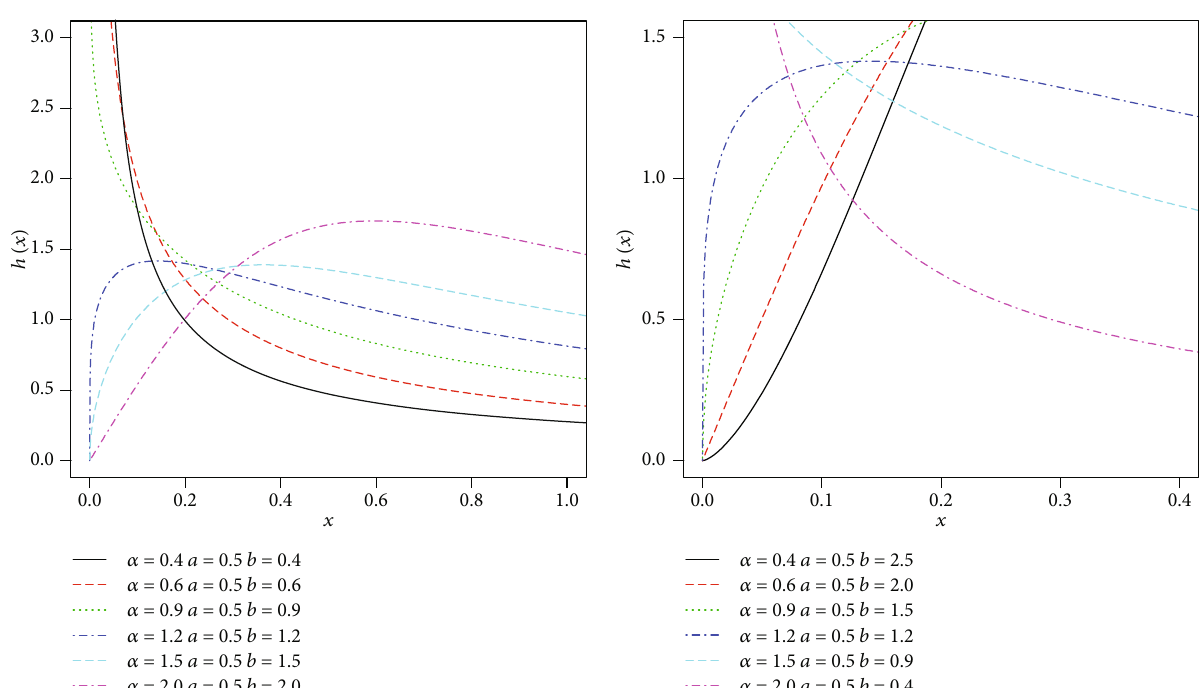
Figure 2: Plots of the hrf of the APTLL